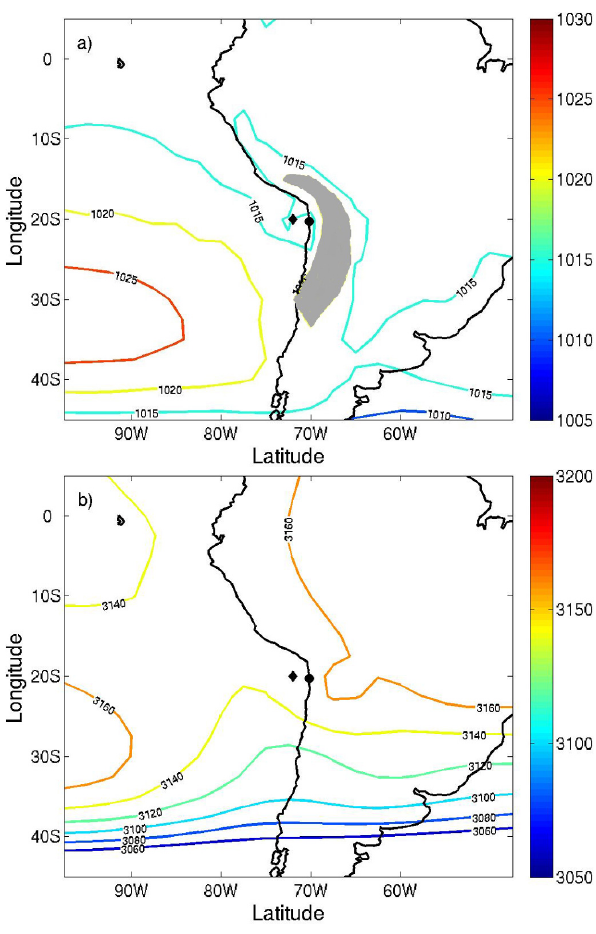
Fig. 1. (a) Composite Sea Level Pressure (16 October–13 Novem- ber 2008). The contours are every 2hPa. The Andes region is shaded to avoid the artificially high sea level pressure region due to the high altitude; (b) Composite 700-hPa geopotential height. The contours are every 20m. The black diamond marks Point Al- pha, and the black dot indicates the location of Iquique. The coastal outline is shown as a black solid